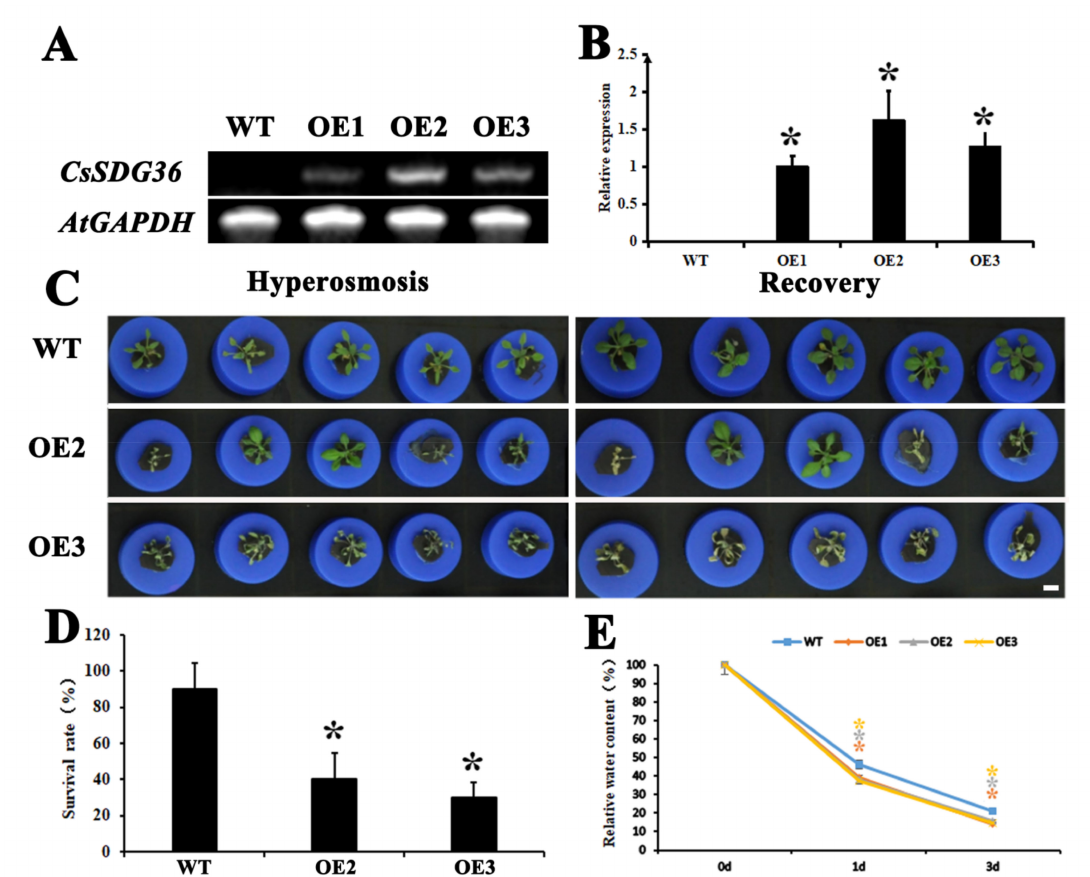
Figure 3. Phenotypic identification of CsSDG36 in hyperosmosis between Arabidopsis seedlings of overexpression lines and wild type. ( A ) Semi-quantitative PCR analysis of CsSDG36 expression in overexpression lines. ( B ) qRT-PCR analysis of CsSDG36 expression in overexpression lines. ( C ) Seedlings after 6-day hyperosmotic treatment (10% PEG 6000) and 2-day recovery (1/4 nutrient solution). ( D ) Survival rates of seedlings after recovery. ( E ) Relative water contents of seedling leaves after hyperosmotic treatment. WT, wild type; OE1, overexpression line 1; OE2, overexpression line 2; OE3, overexpression line 3. Bars = 10 mm. * represents significant difference at p < 0.05 versus the wild type. The results were obtained from three biological experiments with three technical